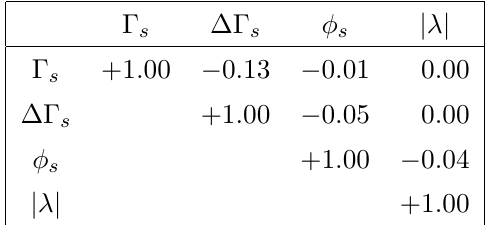
J= K + K (cid:0) for m KK > 1 : 05 GeV, m KK s !